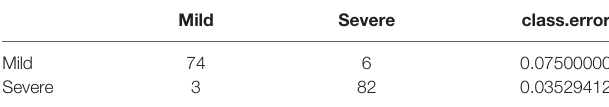
TABLE 5 | Confusion matrix.